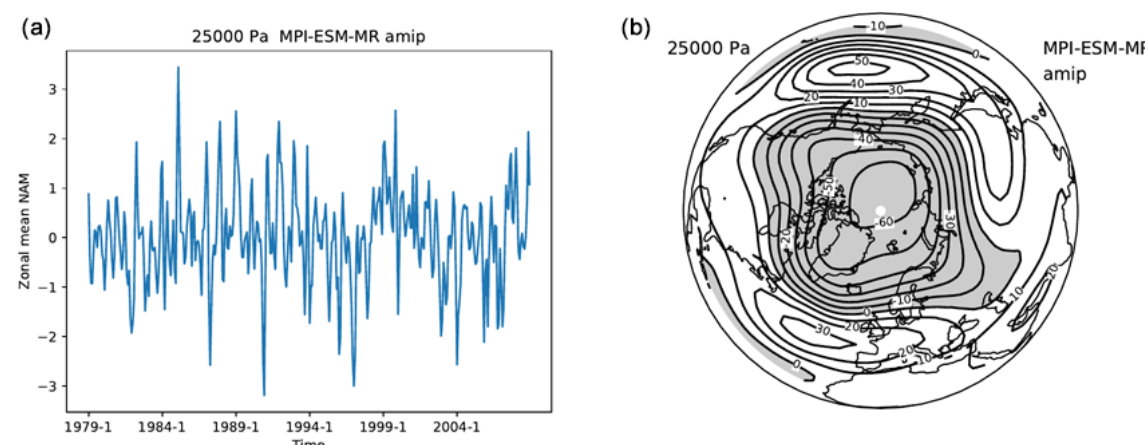
Figure 9. The standardized zonal mean NAM index ( a , unitless) at 250hPa for the atmosphere-only CMIP5 simulation of the Max Planck Institute for Meteorology (MPI-ESM-MR) model, and the regression map of the monthly geopotential height on this zonal-mean NAM index ( b , in metres). Note the variability on different temporal scales of the index, from monthly to decadal. Similar to Fig. 2 of Baldwin and Thompson (2009) and produced with recipe_zmnam.yml ; see details in Sect. 3.2.3.